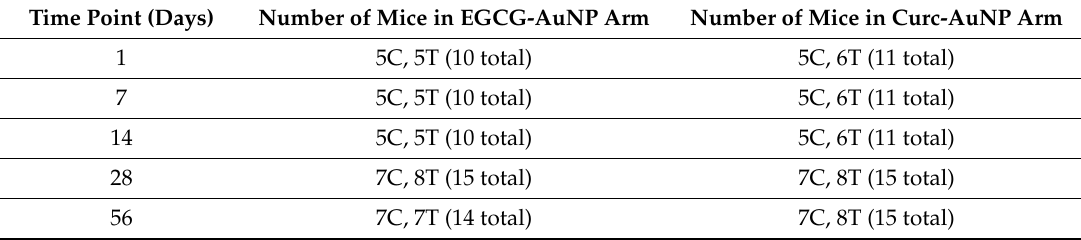
Table 1. Number of mice sacrificed for each time point and study